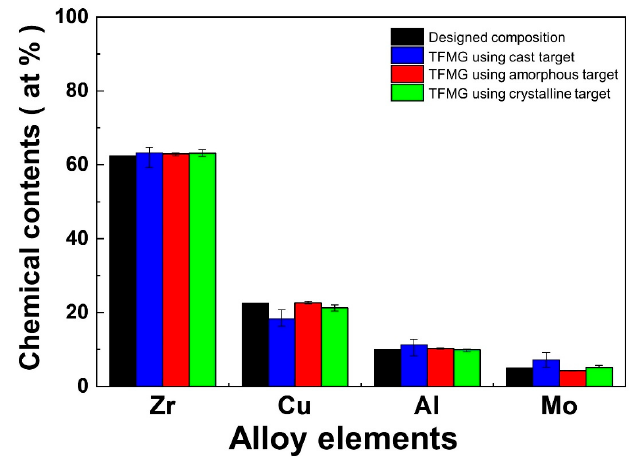
Figure 9. Electron probe microanalysis results of TFMG deposited by casting, and fine crystal targets.